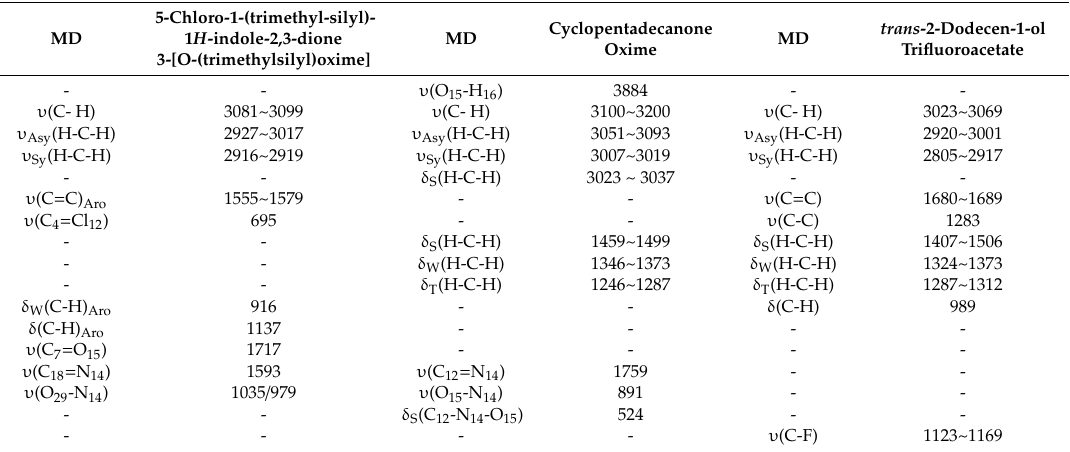
Table 4. Calculated scaled infra-red (IR) frequencies (cm − 1 ) for 5-chloro-1-(trimethylsilyl)-1 H